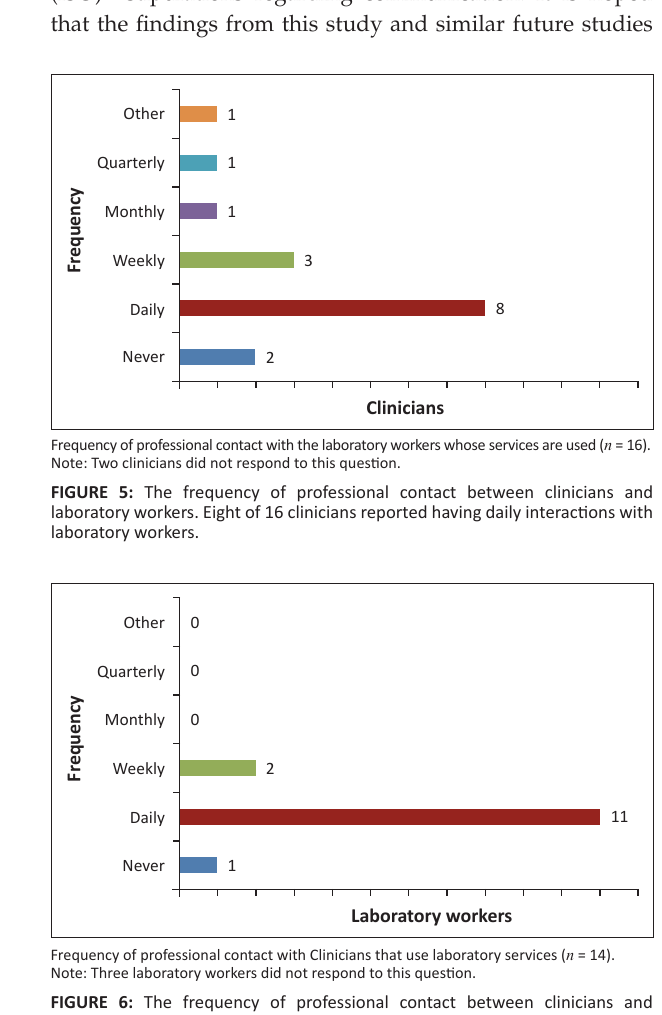
FIGURE 4: Professional factors. The perceptions of laboratory workers regarding the frequency with which test results are used for making clinical decisions.